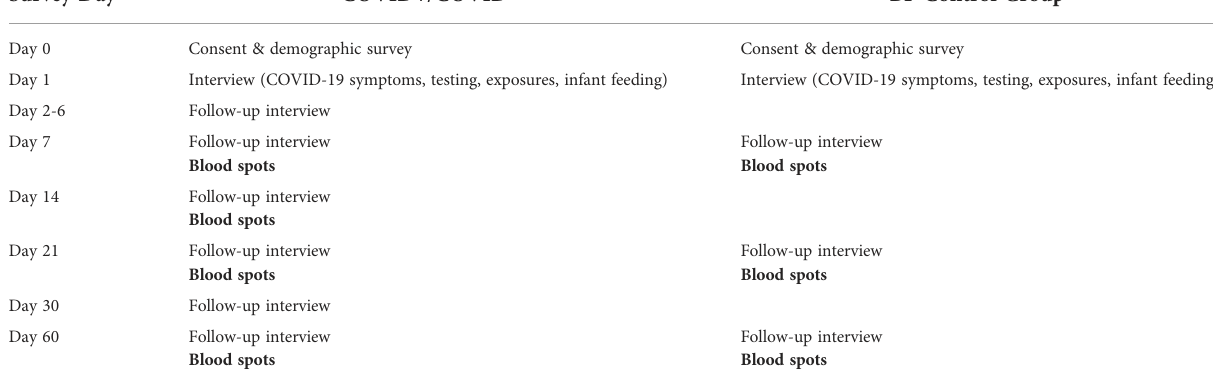
TABLE 2 Summary of data collection timeline by enrollment group.